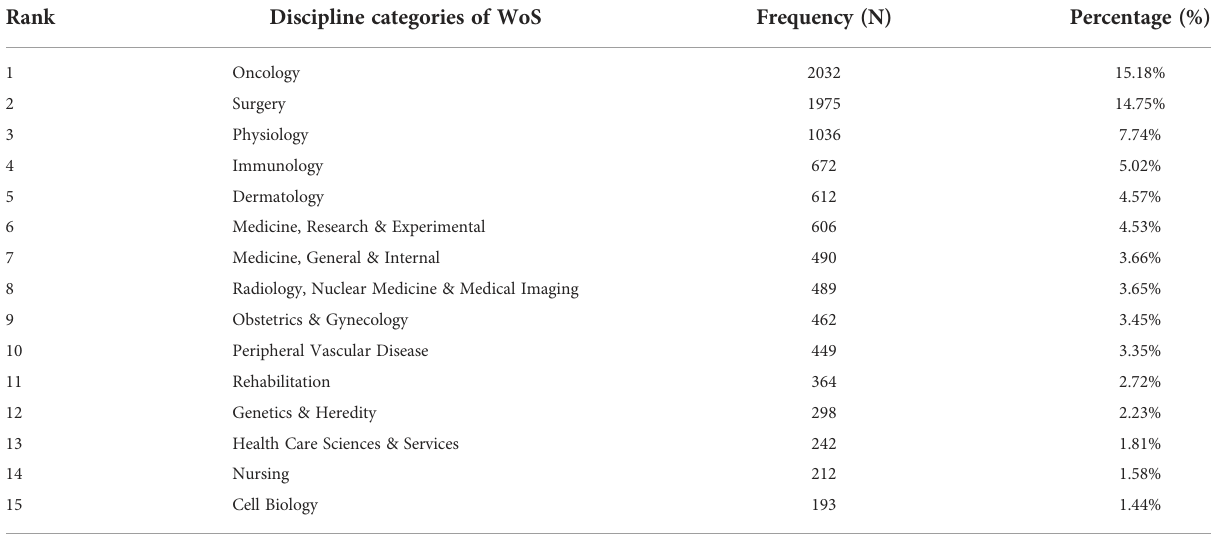
TABLE 2 The discipline category with the most publication